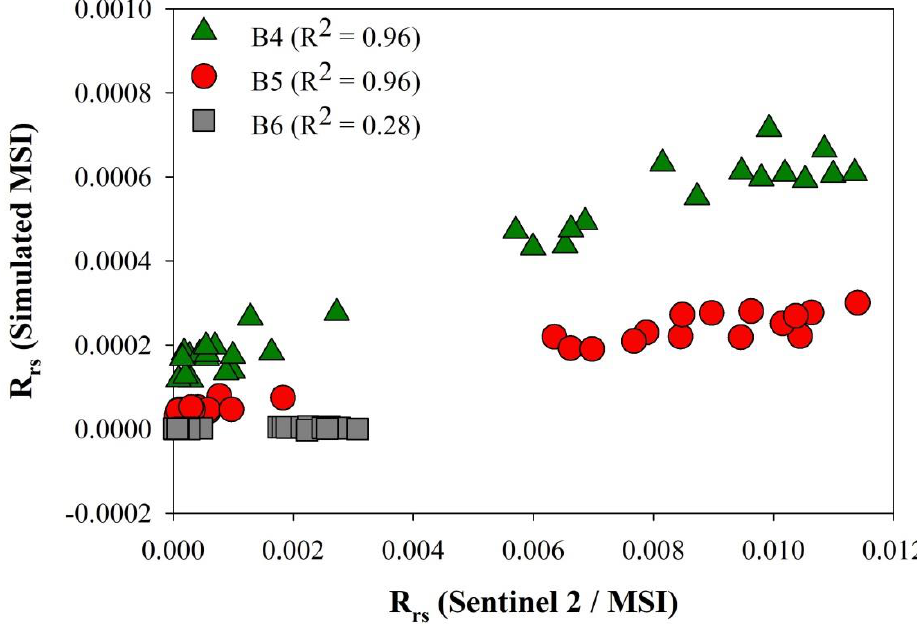
Figure 8. Relationship between R rs values from spectral bands 4, 5 and 6 for the simulated MSI bands and Sentinel-2/MSI image after atmospheric correction with C2X .